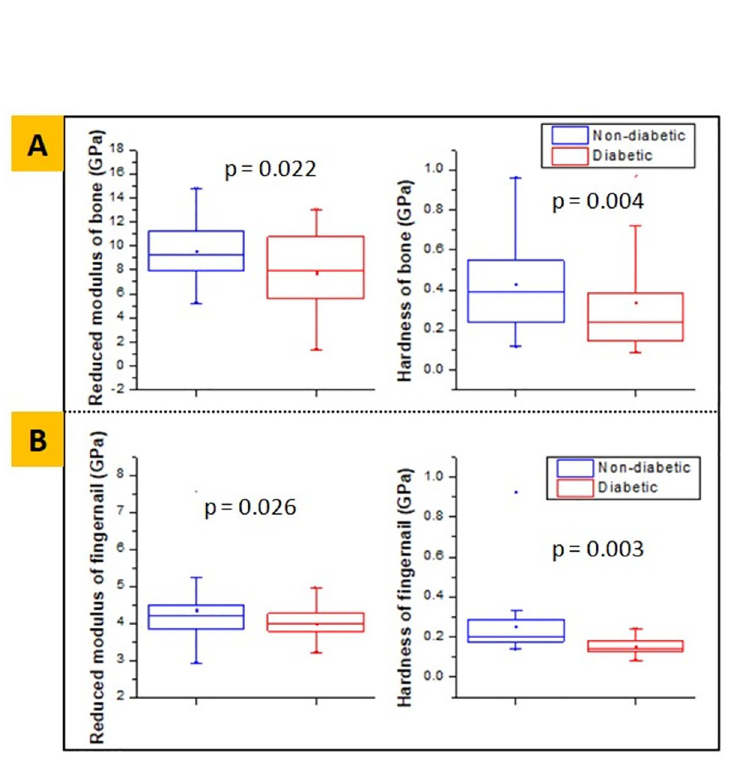
Fig 5. Reduced modulus and hardness obtained from nanoindentation, showing lower mean values in diabetic group for both bone (A) and fingernail (B) respectively.